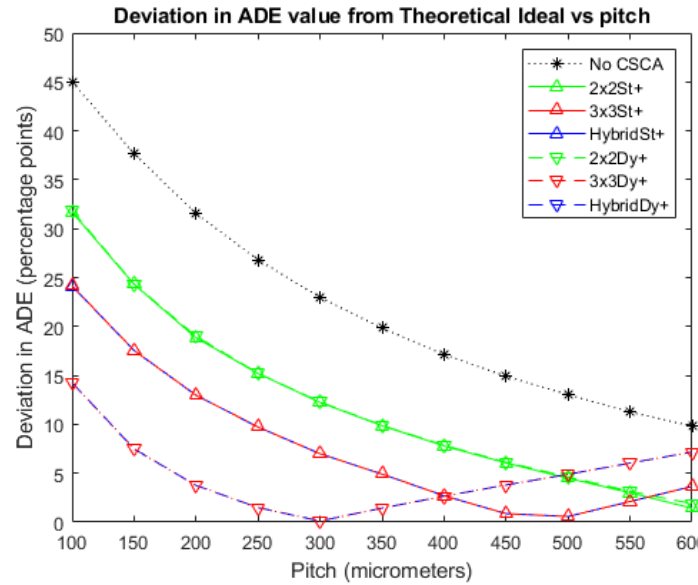
Figure 6. A plot of the difference between each CSCA and the theoretical ADE proposed earlier at an incident photon flux of 10 6 photons mm −2 s −1 . The difference is taken directly from the data for Figure 3 and so is expressed as percentage points. Again, the case where no CSCA is applied is presented for comparison.